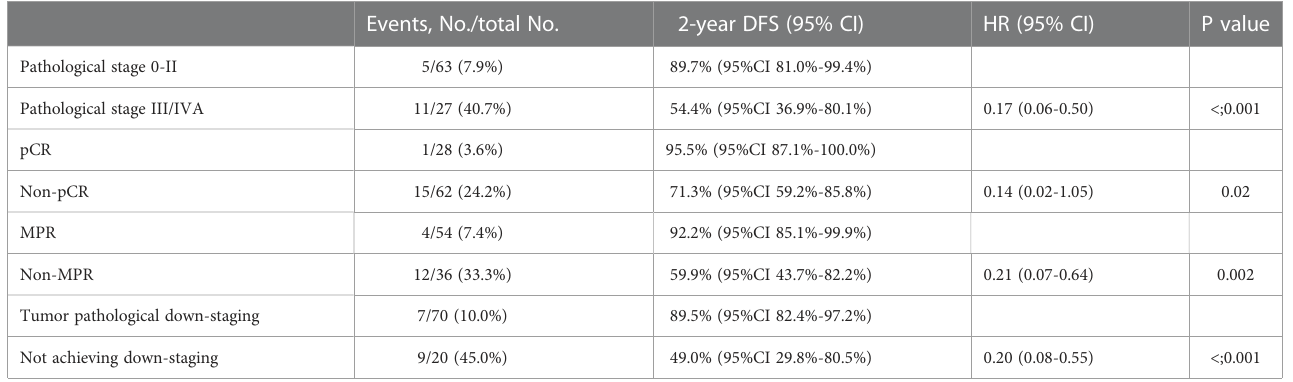
TABLE 4 Comparisons between pathological response subgroups.